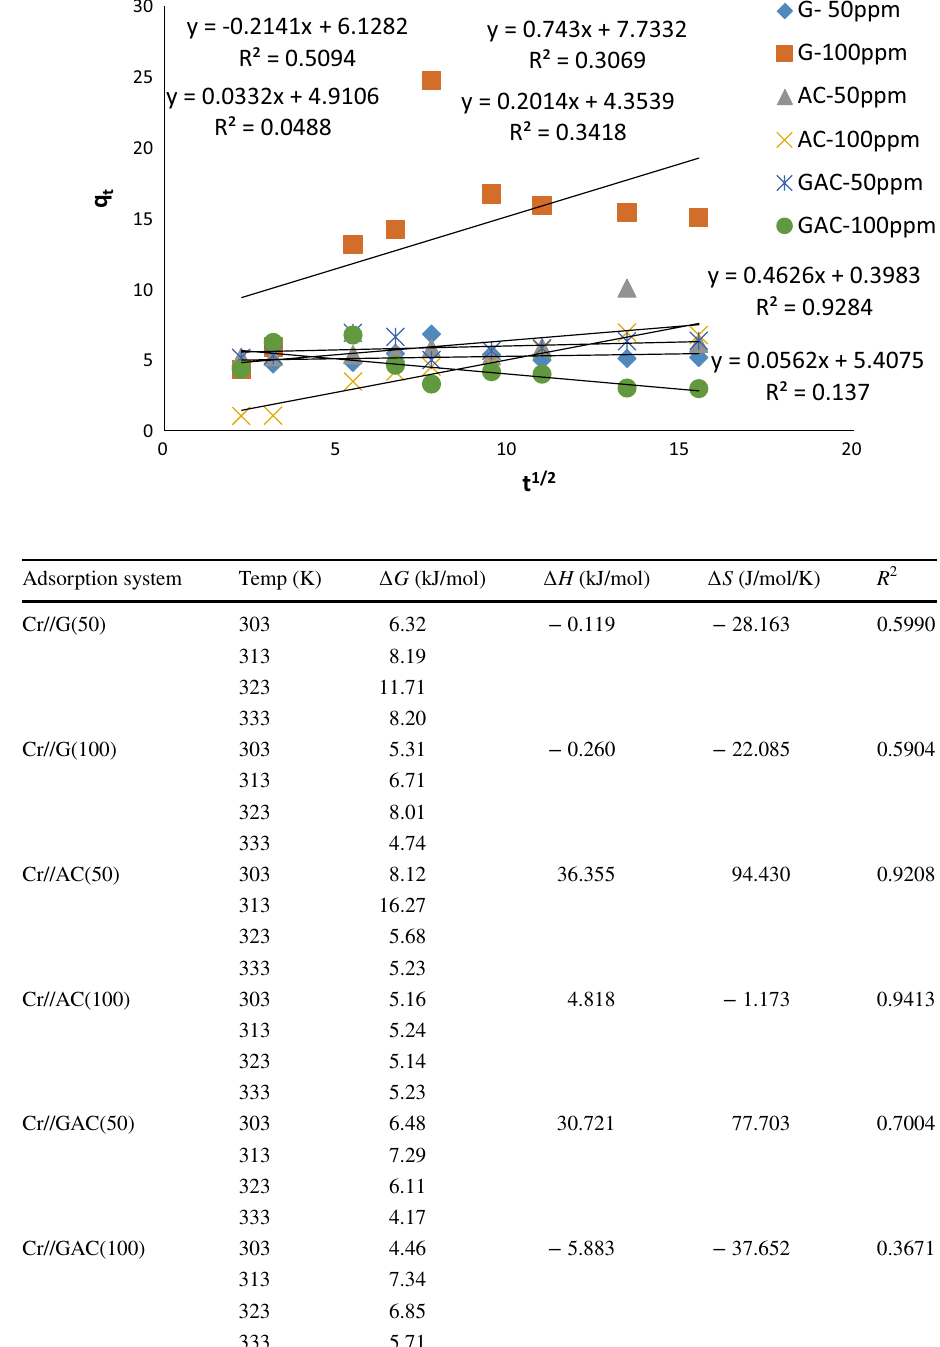
Fig. 16 Linearized plot of intra- particle diffusivity model plot of Cr(VI) adsorption onto G, AC and GAC y = 0.0332x + 4.9106